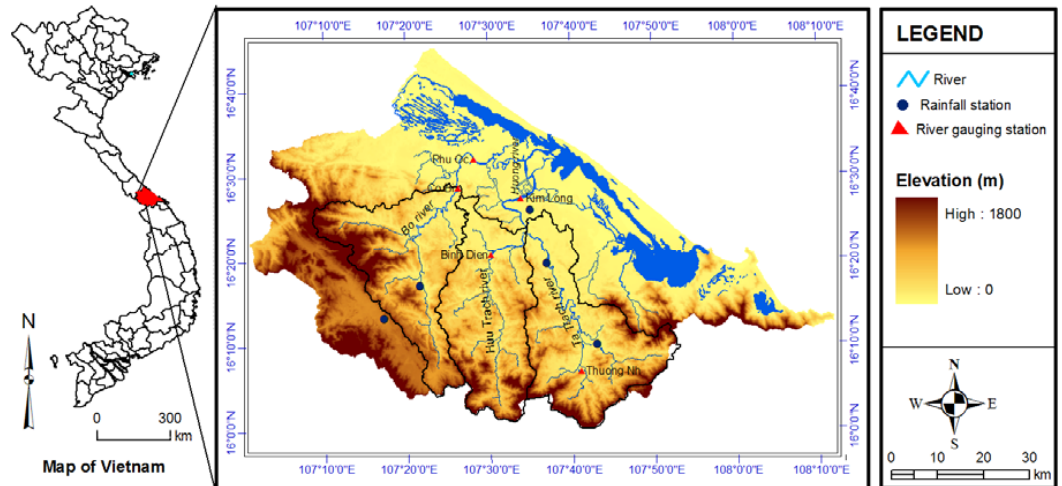
Figure 1. Map of Thua–Thien Hue province showing the location of the Huong River basin, consisting of a floodplain and three upstream mountainous sub-catchments (Ta Trach, Huu Trach and Bo). The topography, river courses, coastal lagoons and the location of the hydro-meteorological stations are also shown.